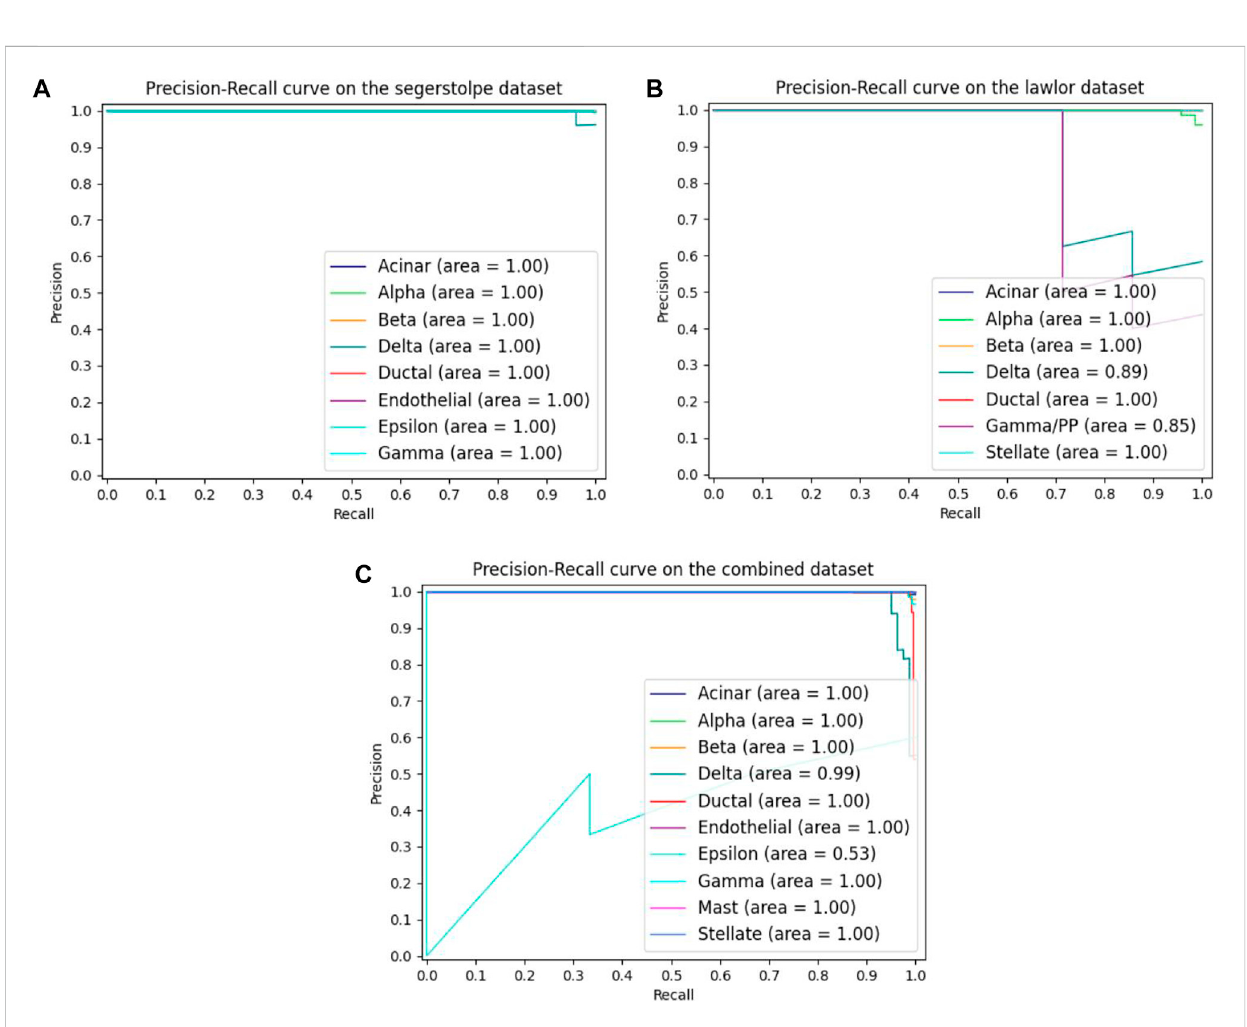
FIGURE 6 The MulCNN ’ s precision recall curves for each cell type on different datasets. (A) Precision recall curves on the segerstolpe dataset. (B) Precision recall curves on the lawlor dataset. (C) Precision recall curves on the combined dataset.